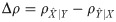
Case III: mixed normal–nonnormal coupling coefficients.(a) Δρ=ρX^∣Y−ρY^∣X at L = 500 as a function of η¯N/μ¯Wb. (b) 1000 independent realizations of Eq (12) and the corresponding Δρ at L = 500 as a function of η¯N/μ¯Wb. η¯N and μ¯Wb are the mean values of η
N and μ
Wb over the span of the time–series. Δρ = 0 and η¯N/μ¯N=1 are shown by dashed, bold lines.